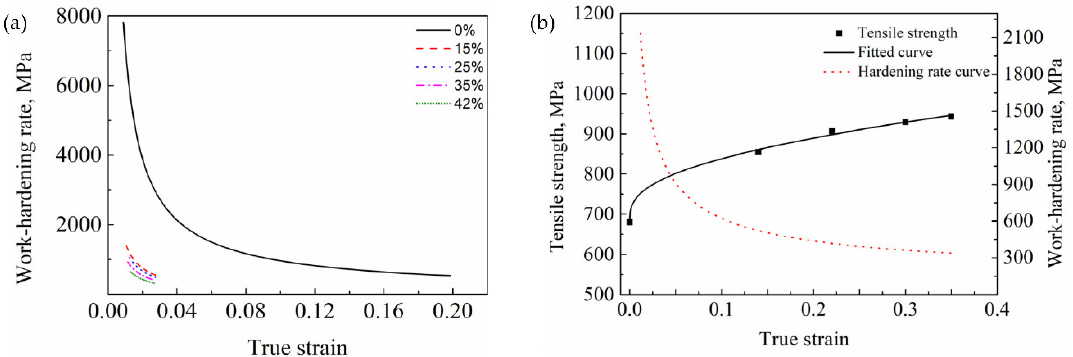
Figure 9. Work-hardening-rate curve of Gr.4 strip for: ( a ) true-stress–strain curves and ( b ) fitting curve of tensile strength.